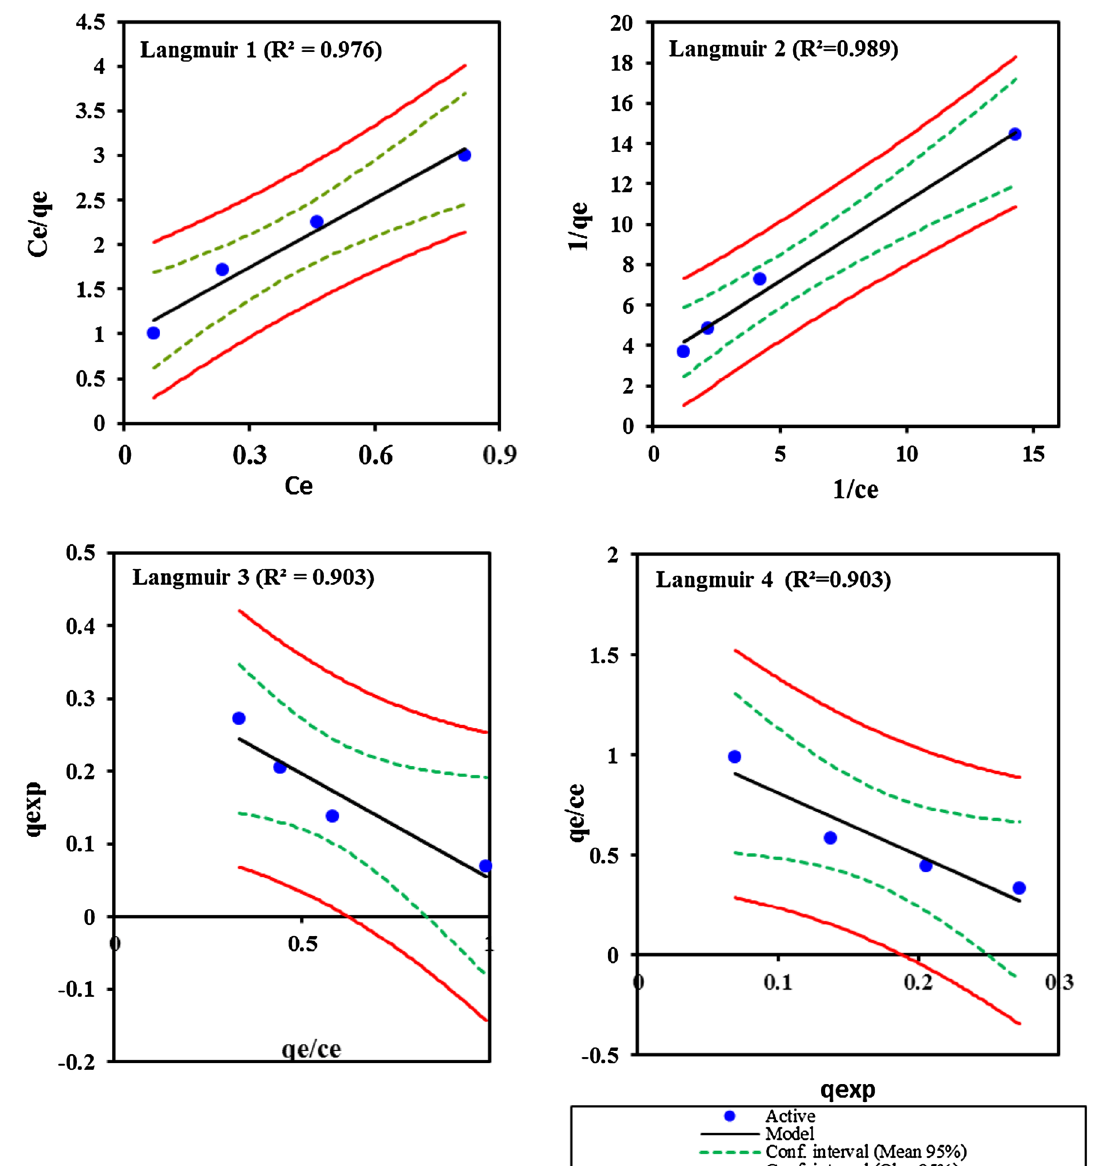
Fig. 1 Different linear forms of Langmuir isotherm obtained using the linear method for the sorption of fluoride onto